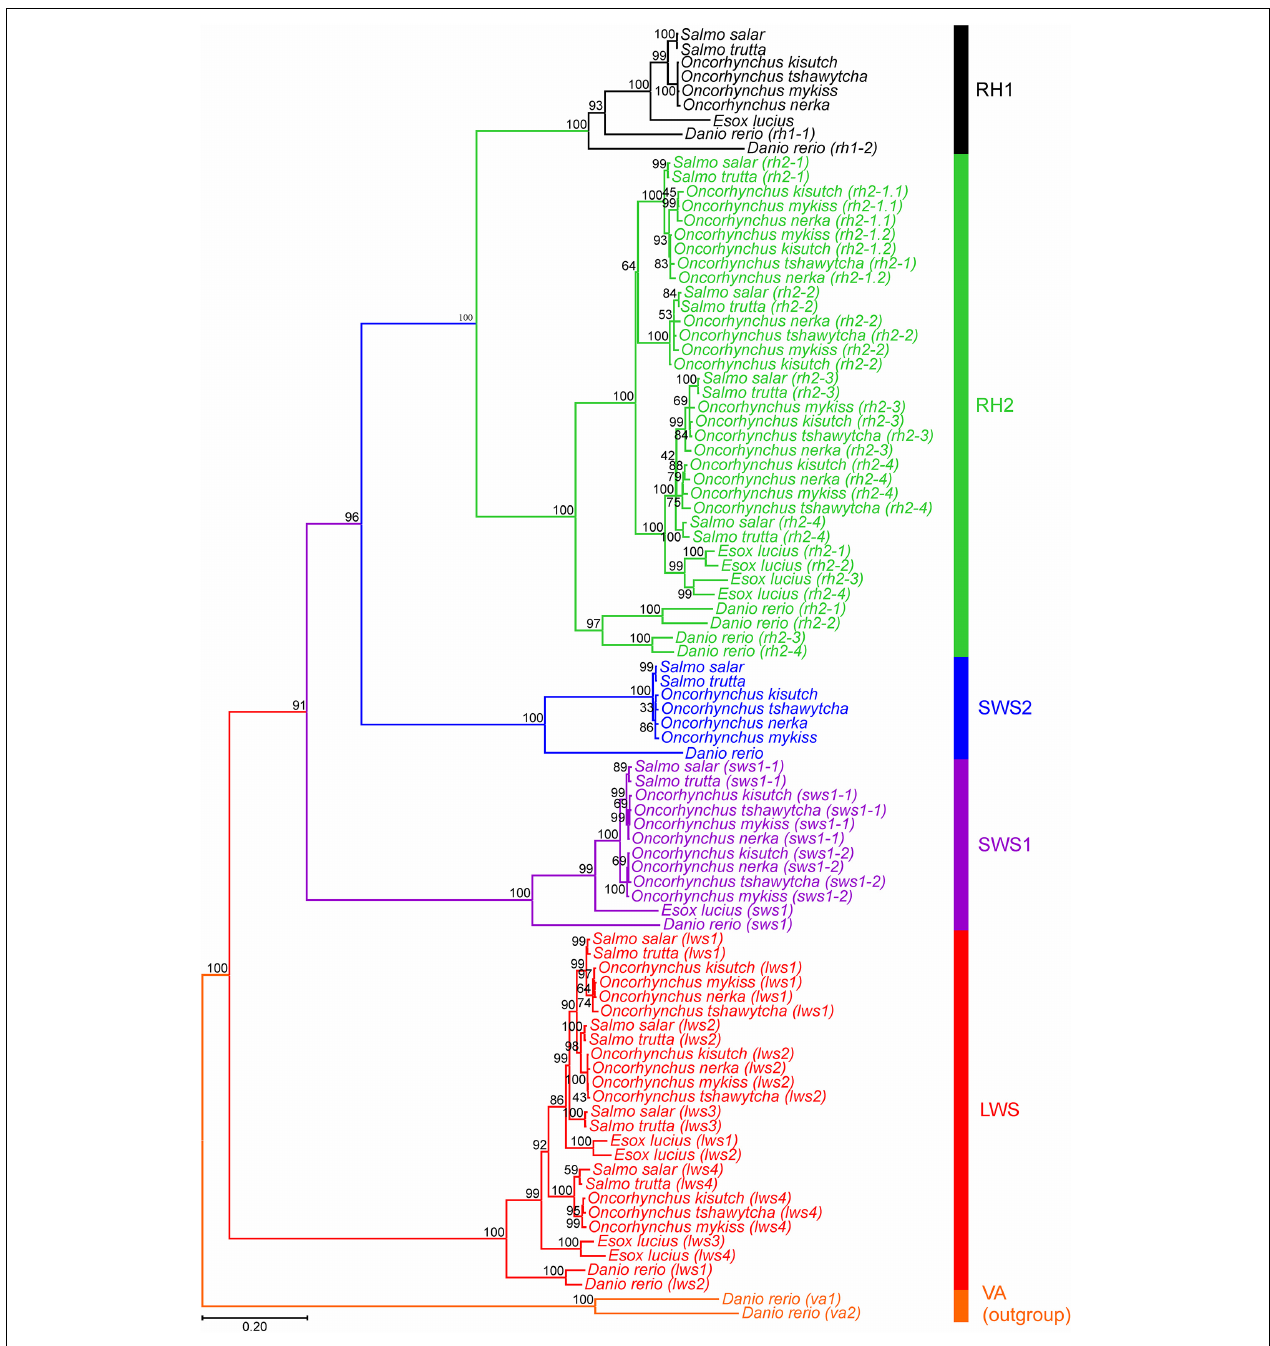
FIGURE 1 | Opsin evolutionary history as inferred by using the Maximum Likelihood method and General Time Reversible model (Nei and Kumar, 2000). The tree with the highest log likelihood (–21,458.16) is shown. The percentage of trees for which the associated taxa clustered together is shown next to the branches. Initial tree(s) for the heuristic search were obtained automatically by applying Neighbor-Join and BioNJ algorithms (Saitou and Nei, 1987), with a bootstrap value of 1,000, to a matrix of pairwise distances estimated using the Maximum Composite Likelihood (MCL) approach (Tamura and Nei, 1993), and then selecting the topology with superior log likelihood value. A discrete Gamma distribution was used to model evolutionary rate differences among sites [5 categories (+ G , parameter = 1.0379)]. The rate variation model allowed for some sites to be evolutionarily invariable [(+ I ), 8.84% sites]. The tree is drawn to scale, with branch lengths measured in the number of nucleotide substitutions per site (indicated by the scale bar). This analysis involved 90 nucleotide sequences, where photopigment genes from six salmonid species and northern pike across five visual opsin classes ( lws , sws1 , sws2 , rh2 , and rh1 ) were compared. Danio rerio (zebrafish) vertebrate ancient (va) opsin 1 and 2 ( va1 and va2 ) sequences were used as an outgroup. Codon positions included were 1st + 2nd + 3rd + noncoding. All positions with less than 95% site coverage were eliminated, i.e., fewer than 5% alignment gaps, missing data, and ambiguous bases were allowed at any position (partial deletion option). There was a total of 996 positions in the final dataset. Evolutionary analyses were conducted in MEGA11 (Tamura et al., 2021).